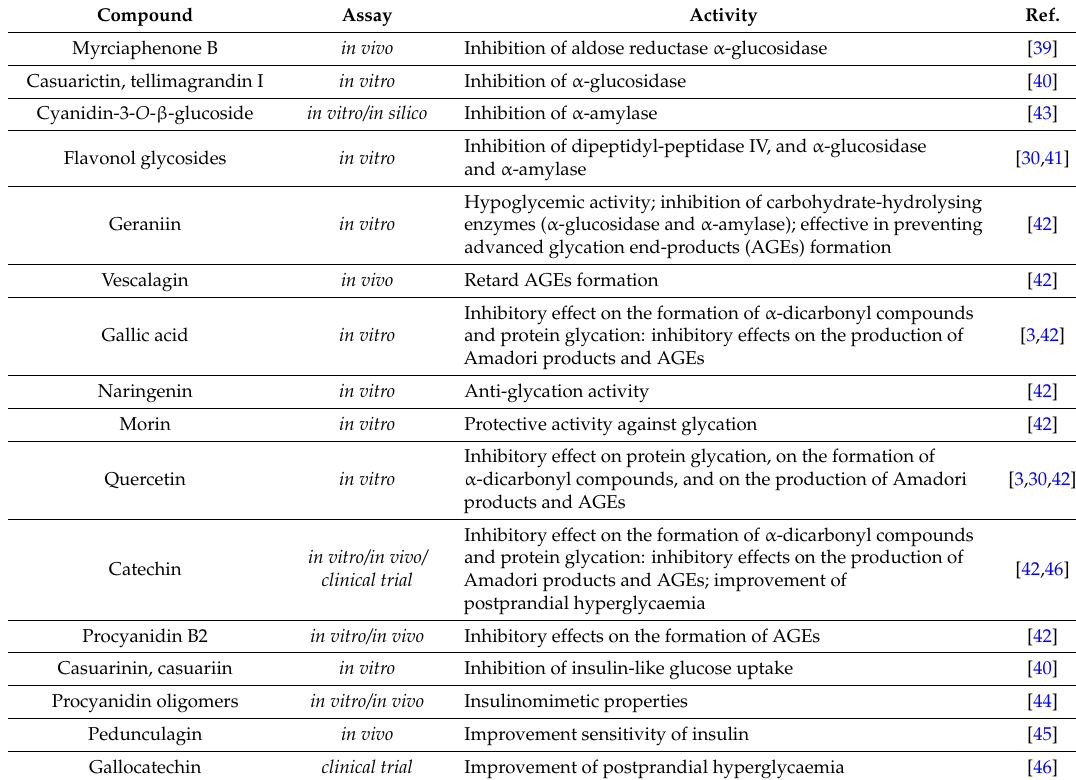
Table 2. Guava leaves’ bioactive compounds related with anti-diabetic properties.